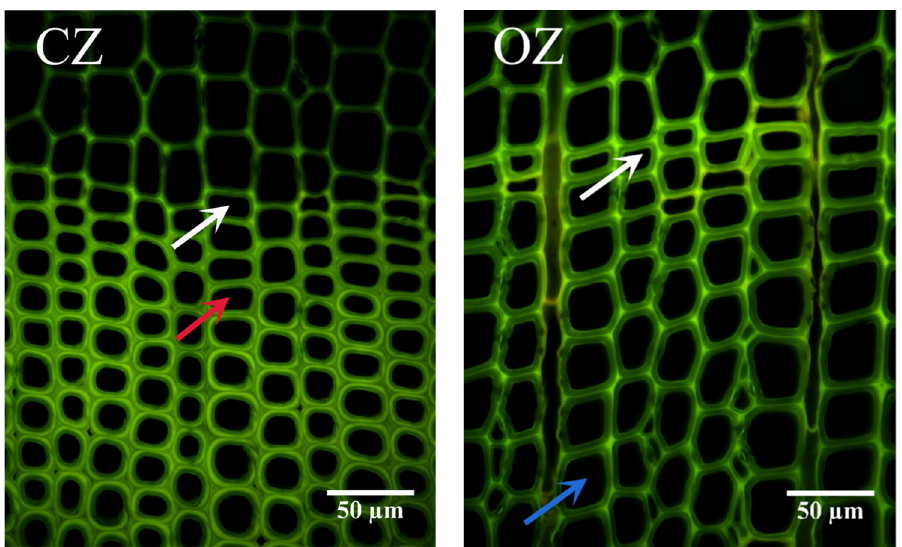
Figure 9. Lignin distribution in the cell walls of latewood in CZ and OZ tracheids. The white arrow points to the late wood, the red arrow points to the CW tracheids near latewood, and the blue arrow points to the early wood.